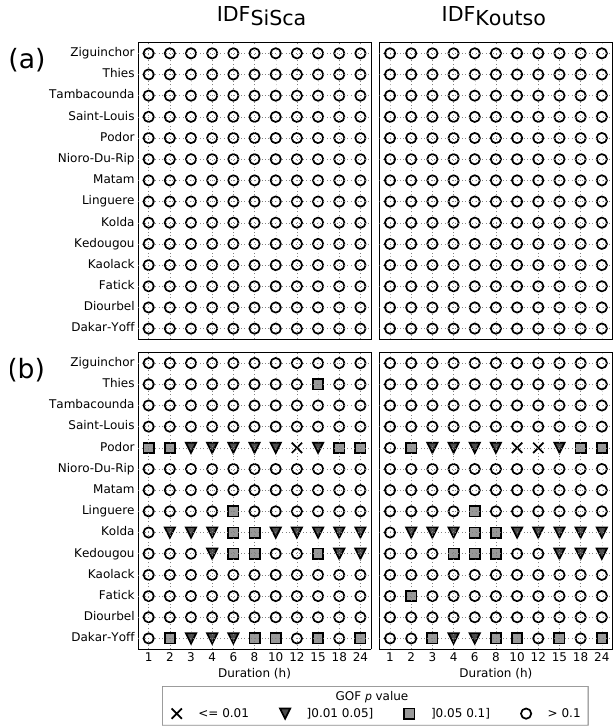
Figure 4. Kolmogorov–Smirnov GOF p values for both IDF mod- els: (a) in calibration mode; (b) in validation mode; left panel for IDF SiSca ; right panel for IDF Koutso